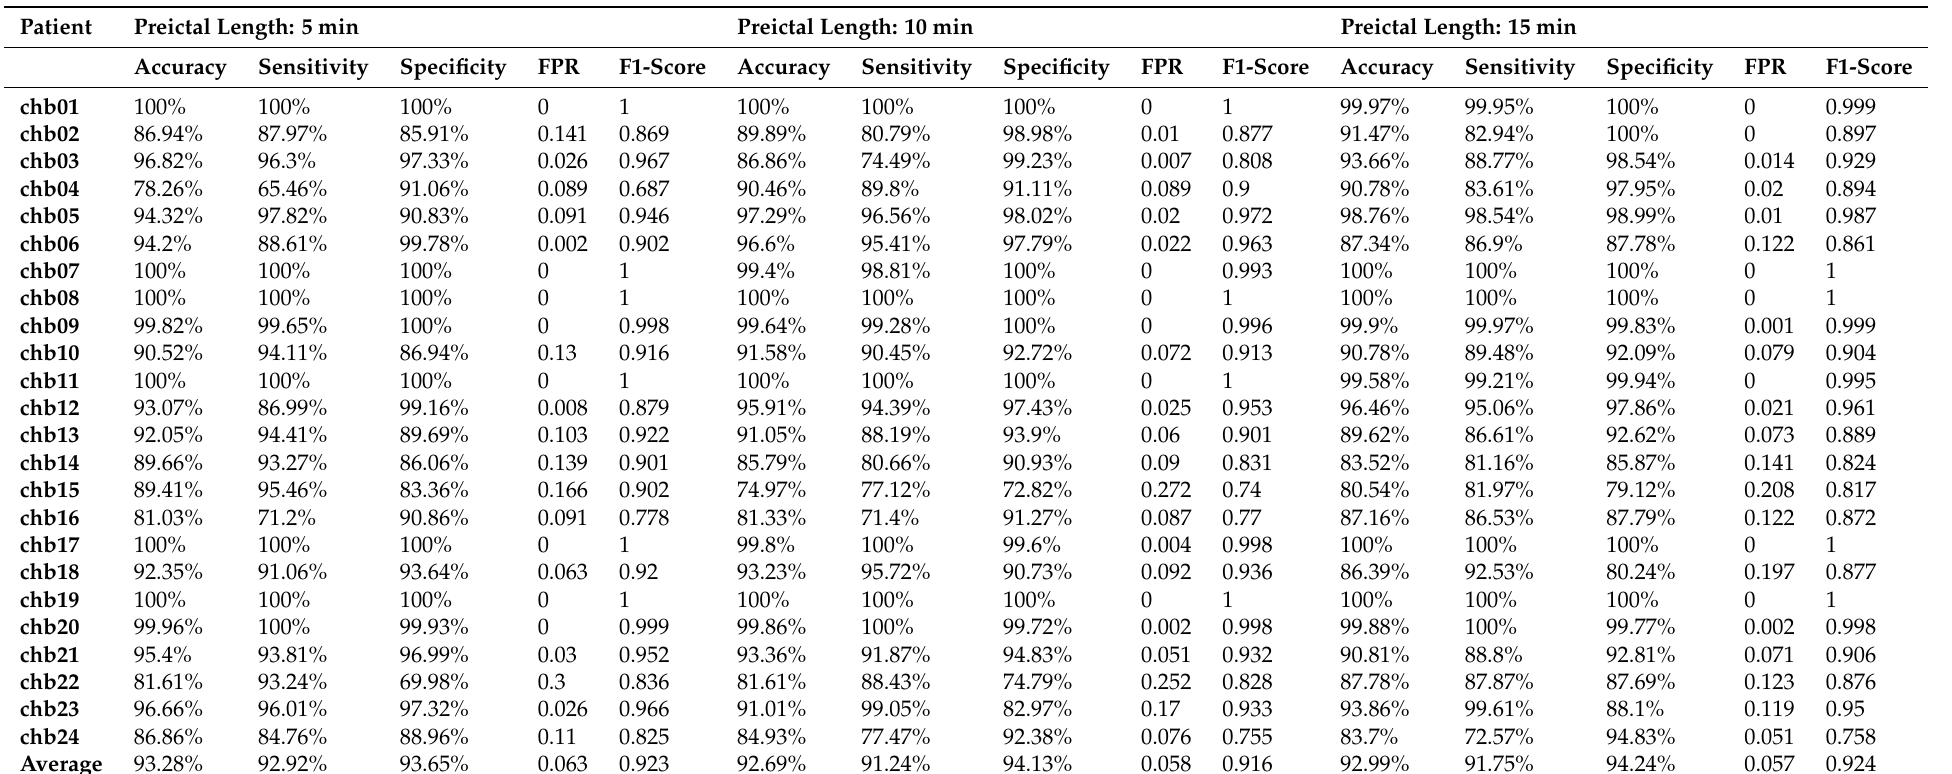
Table 5. Seizure prediction results according to preictal length in 24 patients from the CHB-MIT scalp EEG dataset.